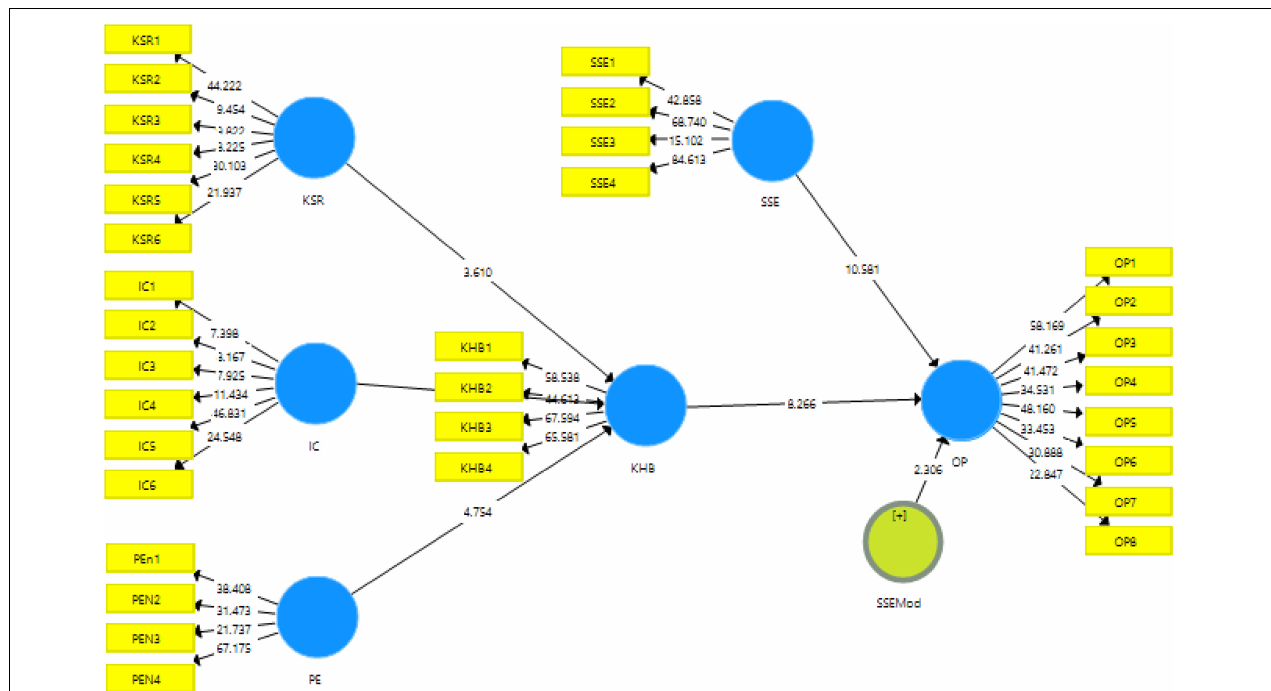
FIGURE 3 | Structural model